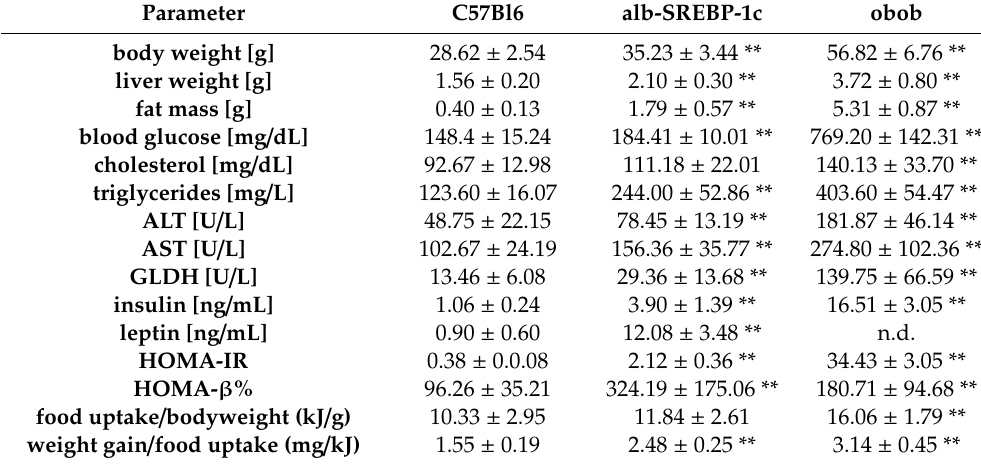
Table 1. Metabolic characterization of the lean mice (C57Bl6), transgenic mice (alb-SREBP-1c) with “healthy” adipose tissue, and of the “sick” adipose tissue obob mice used in the study.